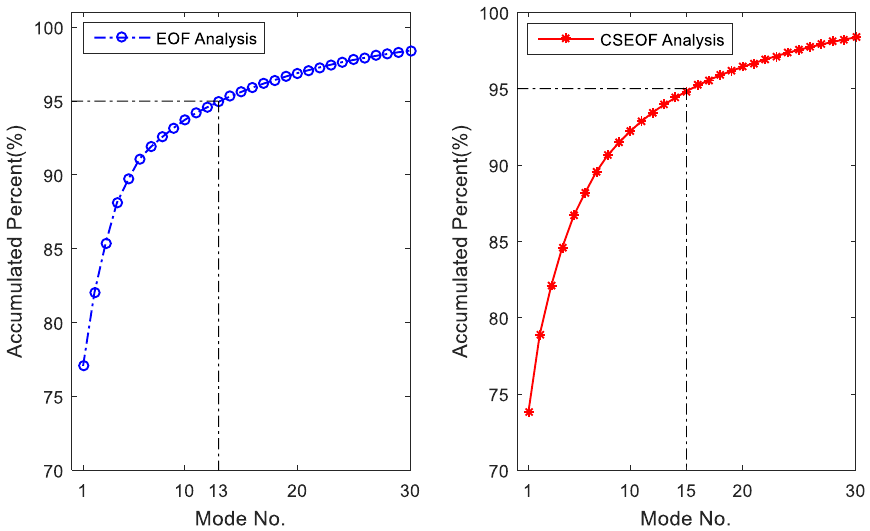
Figure 5. The scree plot of the accumulated percentage of EOF and CSEOF analysis, with 13 leading modes from the EOF, 15 modes from the CSEOF can account for more than 95% of total variance. Therefore, Figure 6 shows the first and second EOF modes, which explain 77.57%